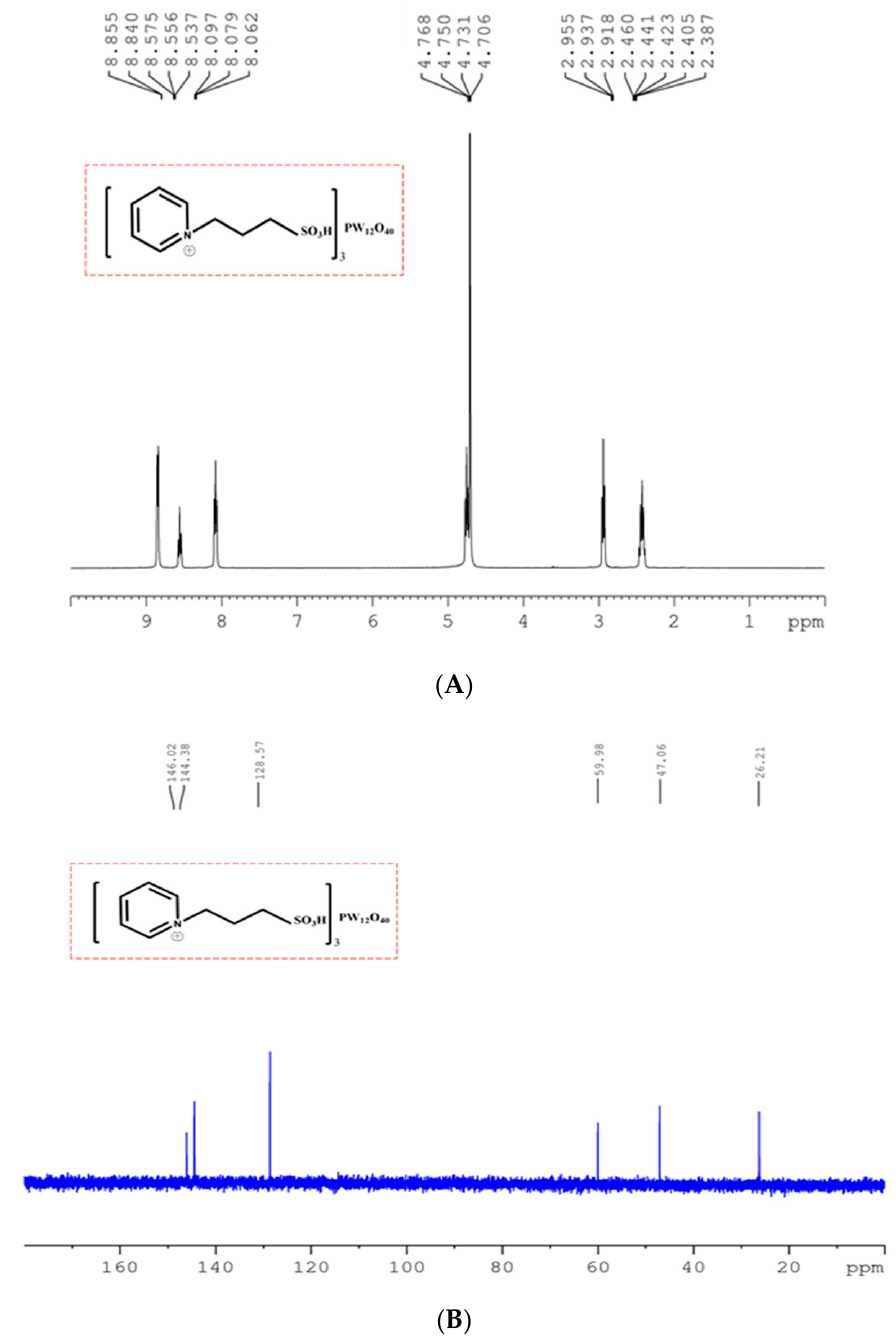
Figure 2. ( A ) 1 H-NMR of [PyPS] 3 PW 12 O 40 , ( B ) 13 C-NMR of [PyPS] 3 PW 12 O 40 .